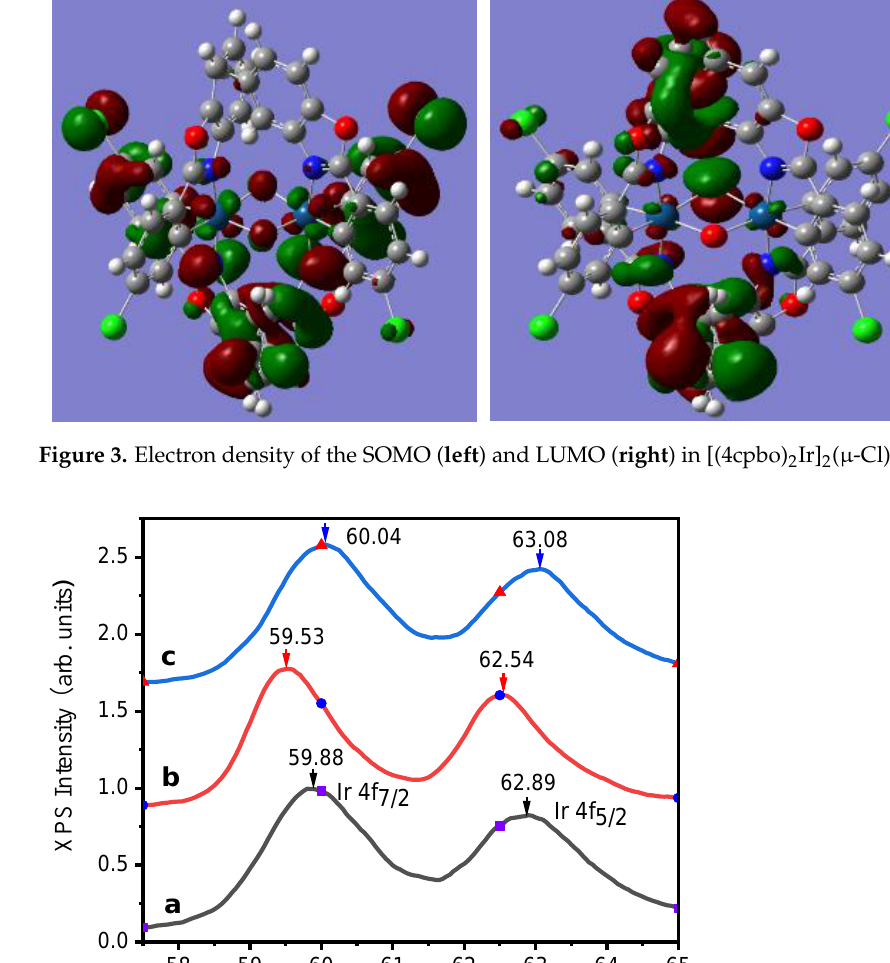
Figure 4. Ir 4f XPS spectra of ( a ) compound 1 , ( b ) (4cpbo) 2 Ir III (μ -Cl), and ( c ) [(dfpbo) 2 Ir IV (μ -O)] 2 . The (FAB+) (Fast Atom Bombardment) spectrum of 1 (Figure 5) shows medium-intensity